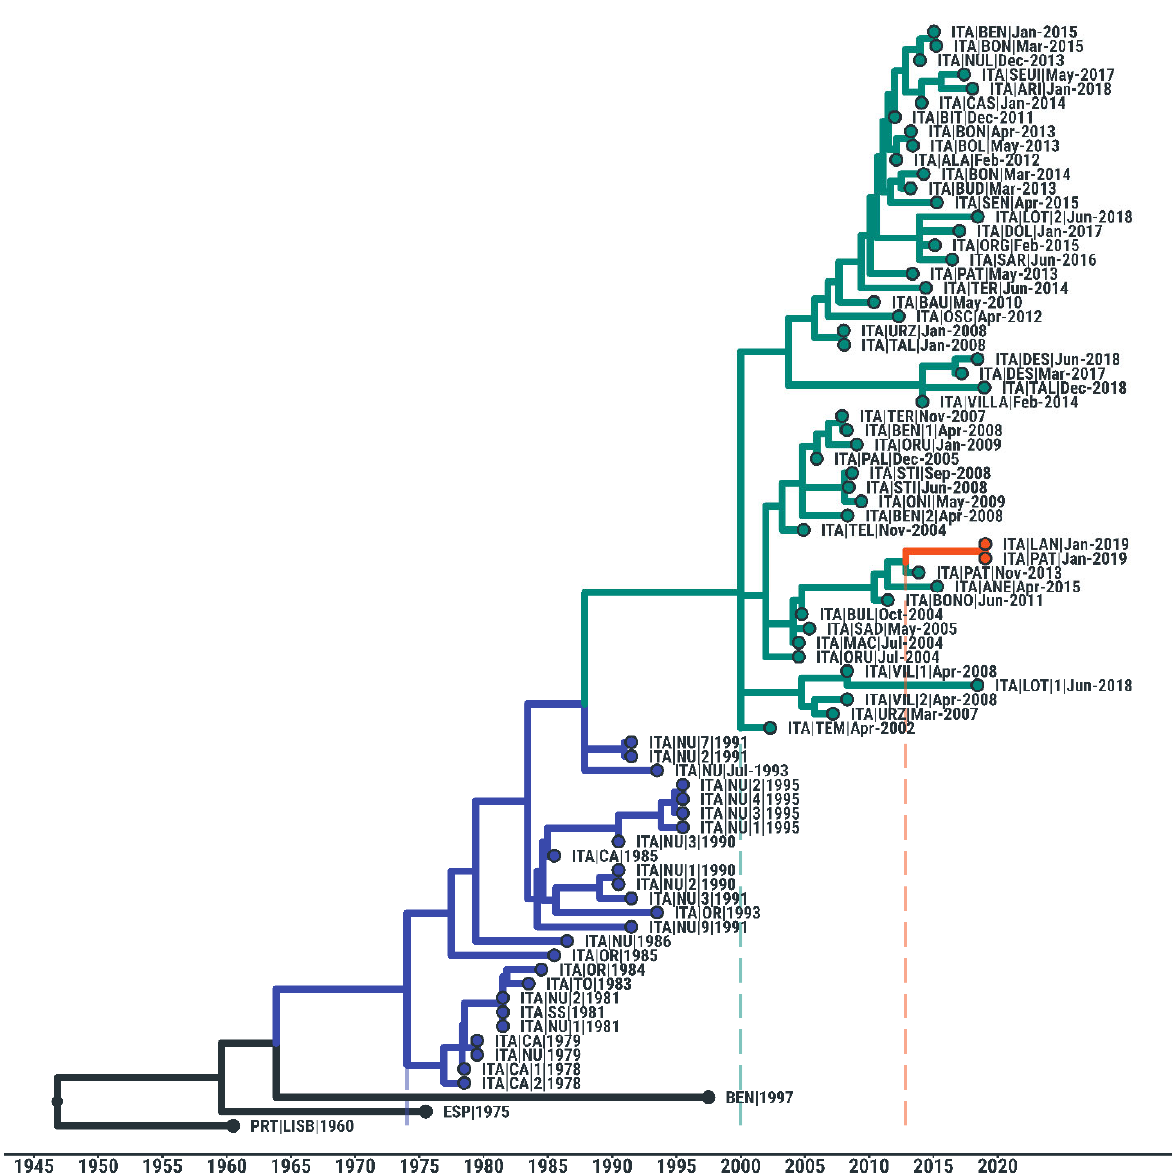
Figure 5. Time-scaled phylogeny of 75 ASF viruses isolated from Sardinia between 1978 and 2019. Colored branches indicate phylogenetic clades that include: (i) ASF viruses collected between 1978 and 1995 (blue), (ii) viruses isolated after 2000 (green), and (iii) the two 2019 ASFV isolates with the microhomology-mediated deletion (orange).